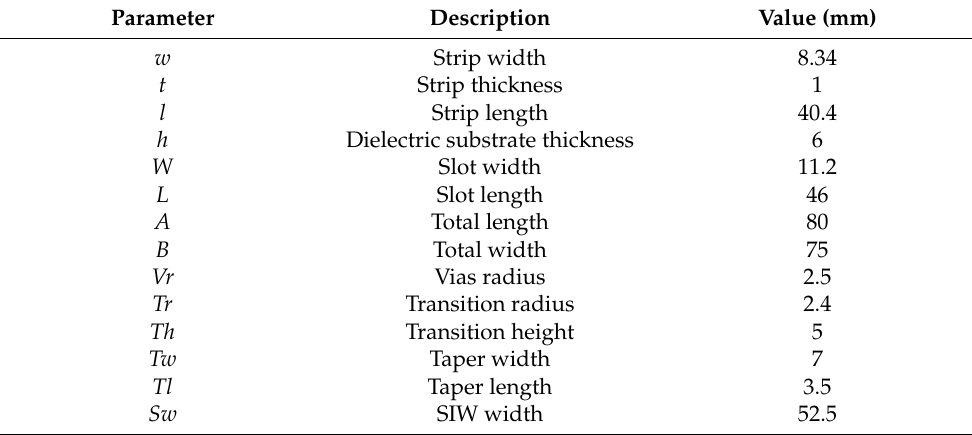
Table 1. Final antenna design parameters.